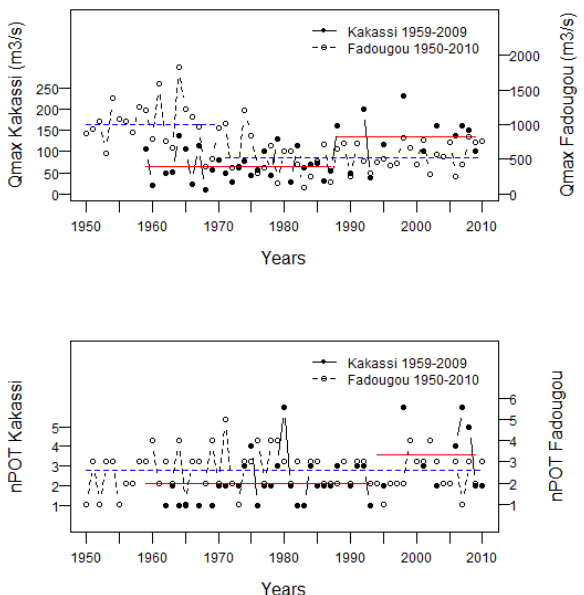
Figure 6. Qmax and nPOT of long-term time series and segmenta- tion according to the Pettitt break test. The dashed blue lines (solid red lines) represent the mean value of the flood index for each sub- period at Fadougou